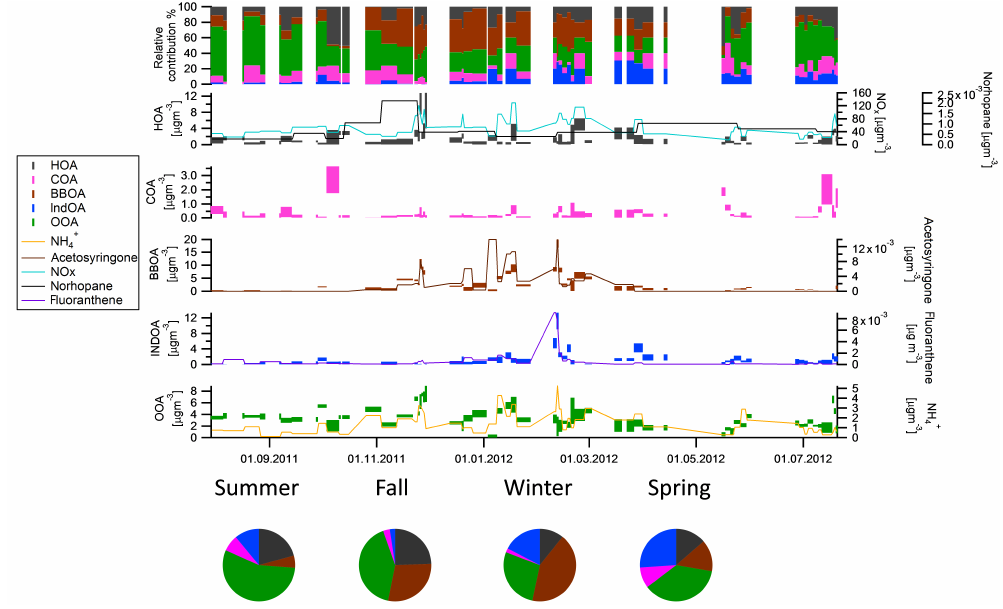
Figure 6. offline-AMS: (a) PMF factors relative contributions. (b) Time series of PMF factors and corresponding tracers. Bars denote the model